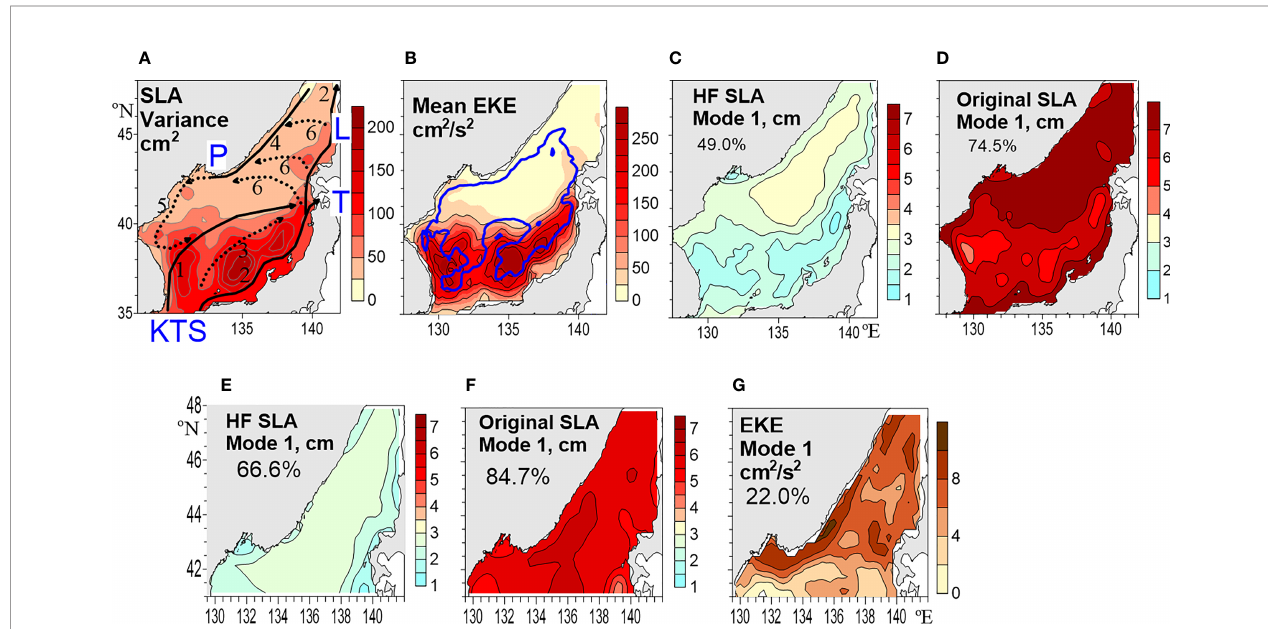
FIGURE 1 | (A) Sea level variance (cm 2 ). Currents are schematically shown by arrows and labeled by numbers: the East Korea Warm Current (EKWC) and its continuation off the coast by 1, the Tsushima Warm Current (TWC) by 2, the East Sea Current by 3, the Primorye (Liman) Current by 4, the North Korea Cold Current (NKCC) by 5, the western branches of the TWC by 6; the intermittent currents are shown by the dotted lines. Peter the Great Bay is marked by the letter P, the KTS, Tsugaru and La Perouse (Soya) Straits are marked as KTS, T, and L, respectively. (B) Time-averaged EKE from the satellite altimetry data (cm 2 /s 2 ); 2000-m isobath is shown by the blue contour. EOF 1 (cm) from the (C, E) high-frequency (HF) and (D, F) original SLA for the (C, E) entire and (D, F) northern JES. (G) EOF 1 (cm 2 / s 2 ) from EKE in the northern JES. Contours are shown for every 25 cm 2 in (A) , 25 cm 2 /s 2 in (B) , 0.5 cm in (C, E, F) , 1 cm in (D) , and 2 cm 2 /s 2 in (G)